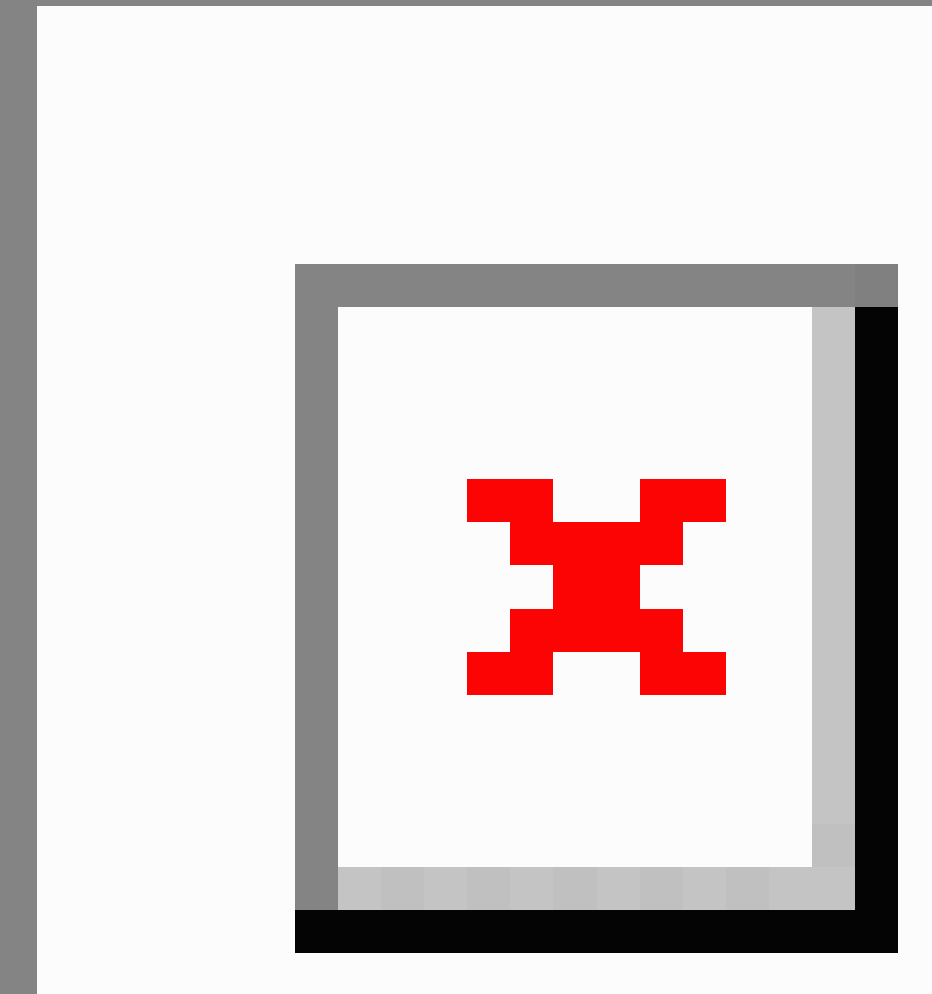
Figure 5. Diffusion of government Weibo accounts